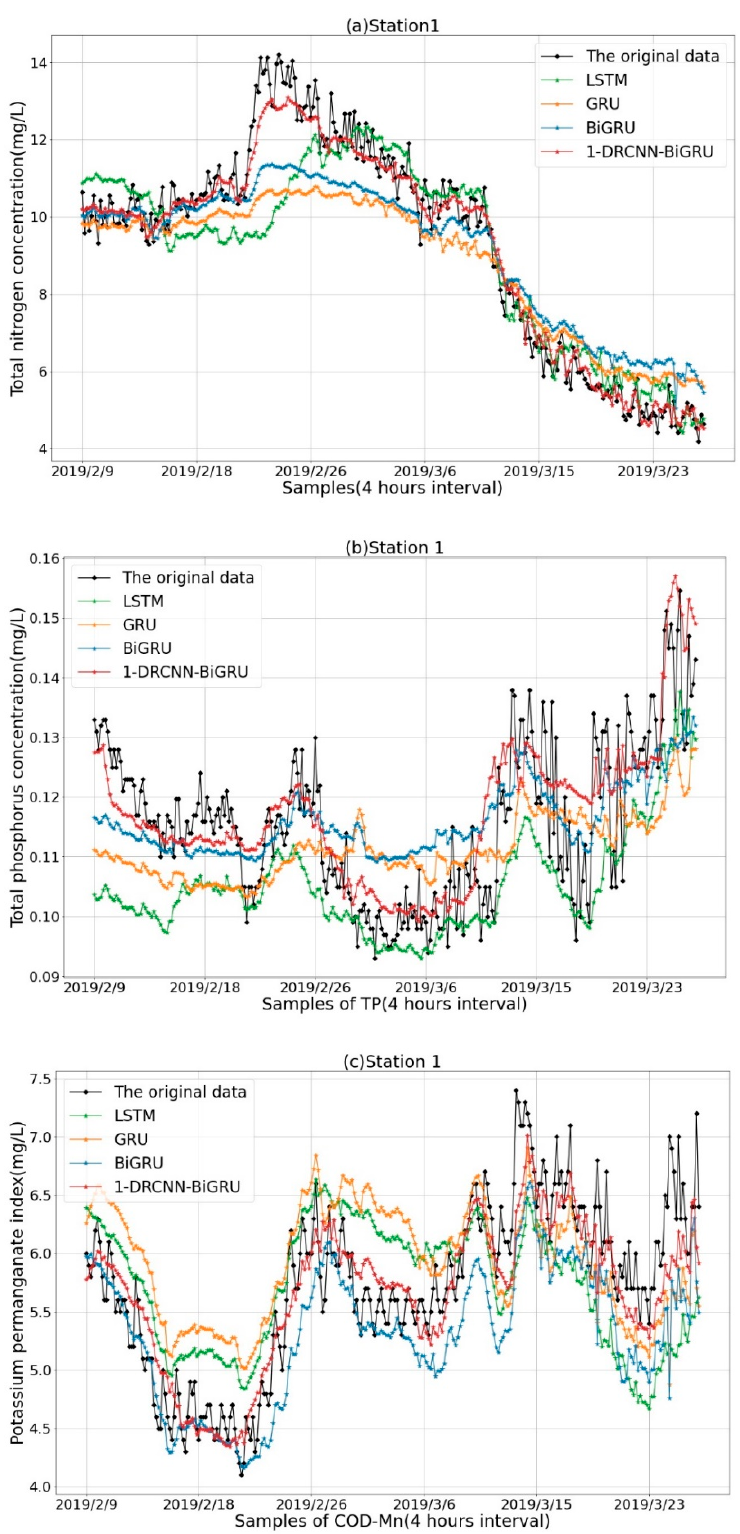
Figure 7. ( a ) Prediction results of total nitrogen (TN) in station 1. ( b ) Prediction results of total phosphorus (TP) in station 1. ( c ) Prediction results of potassium permanganate index (COD-Mn) in station 1.